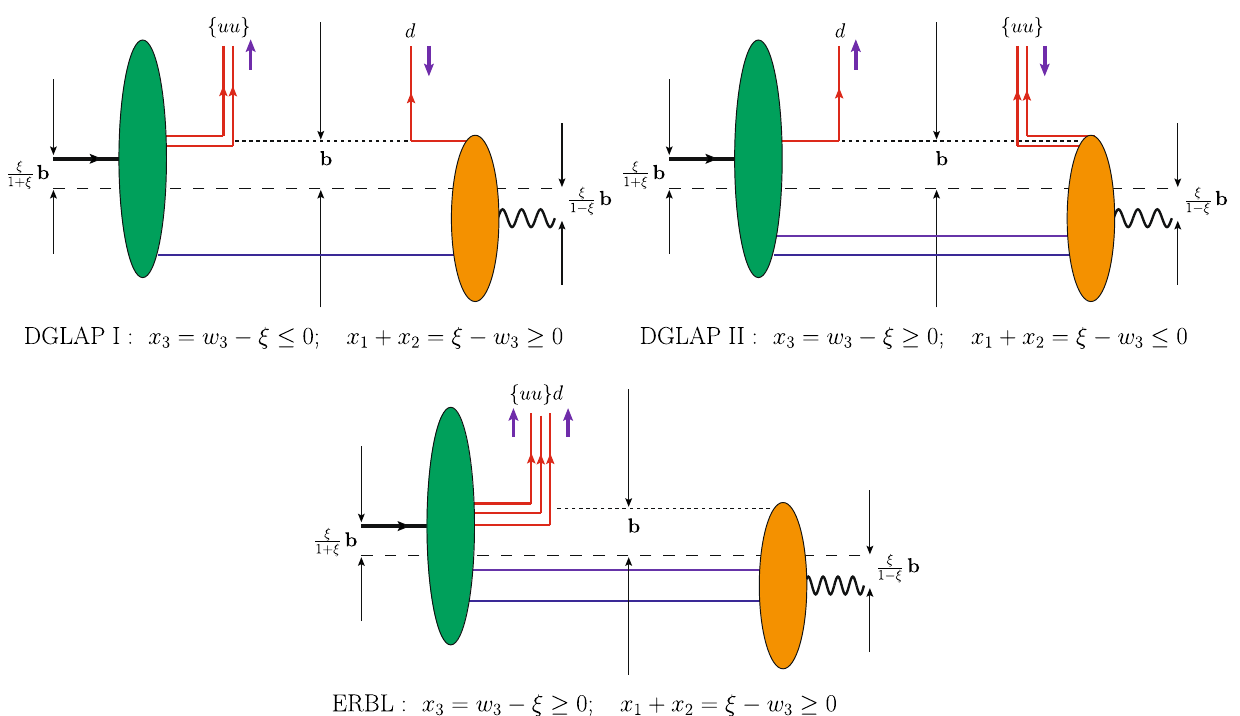
Fig. 2 Impact parameter space interpretation for the v 3 -integrated uud proton-to-photon TDA in the DGLAP-like I, DGLAP-like II and in the ERBL-like domains. Solid arrows show the direction of the positive longitudinal momentum